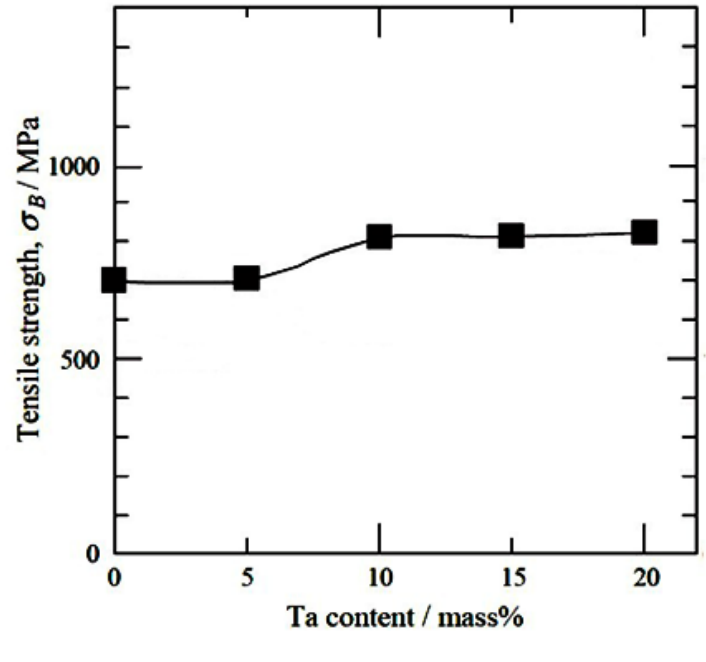
Figure 7. Effect of alloying addition on tensile strength of Ti-XNb-XTa-5Zr [89]. Reprinted with permission from [89]. Copyright 2005